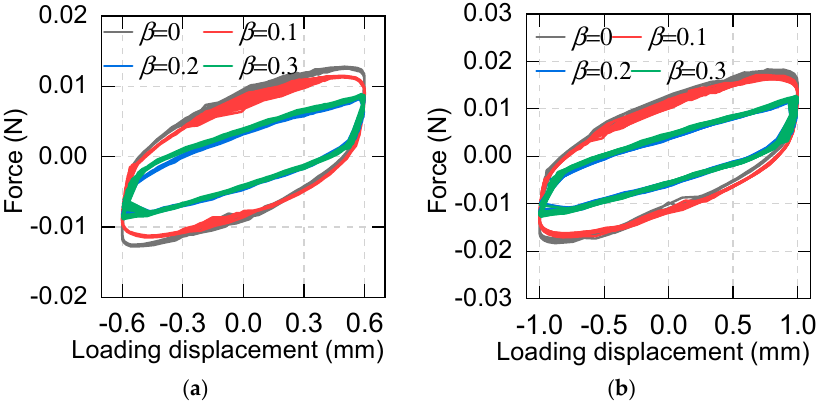
Figure 10. Hysteretic curves of the asphalt specimen with different HCC mass ratios at 0.1 Hz and 20 °C: ( a ) maximum displacement of 0.6 mm; ( b ) maximum displacement of 1 mm.